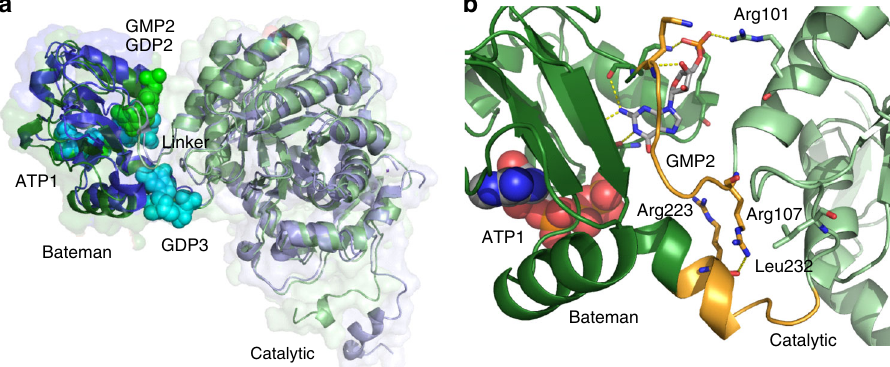
Fig. 6 Relative orientation of the catalytic and the regulatory domain. a Cartoon and surface representation of superposed monomers A from TbIMPDH- ATP1/GMP2 (green) and from AgIMPDH-ATP1/GDP2/GDP3 (blue, PDB 5TC3). Nucleotide atoms are shown as spheres. Both structures adopt an almost superimposable relative domain orientation. b Detailed view of the linker region (orange) between the Bateman (dark green) and the catalytic domains (light green) of TbIMPDH-ATP1/GMP2. The fl ipped conformation of GMP enables a direct interaction with residue Arg101 in the catalytic domain. Further stabilization is provided by an interaction of Arg107 and Arg223. ATP atoms are shown as spheres, while GMP and the GMP-binding residues as well as interface stabilizing residues are represented as sticks. Key interactions are shown as yellow